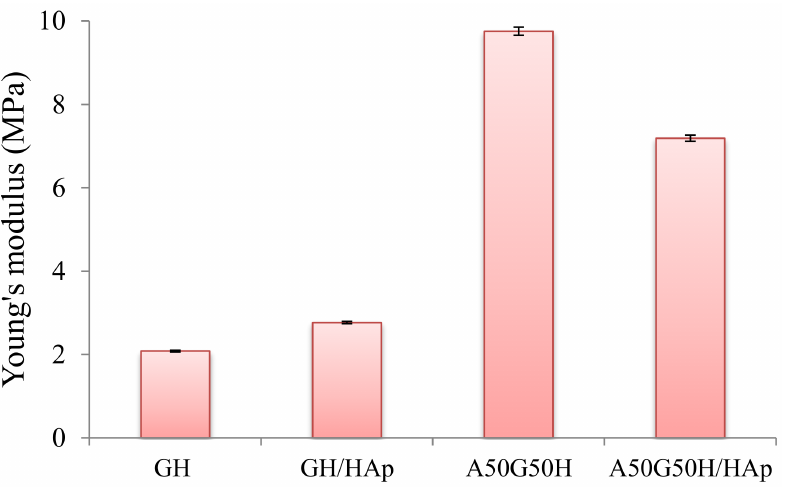
Figure 4. Young’s modulus of hydrogel